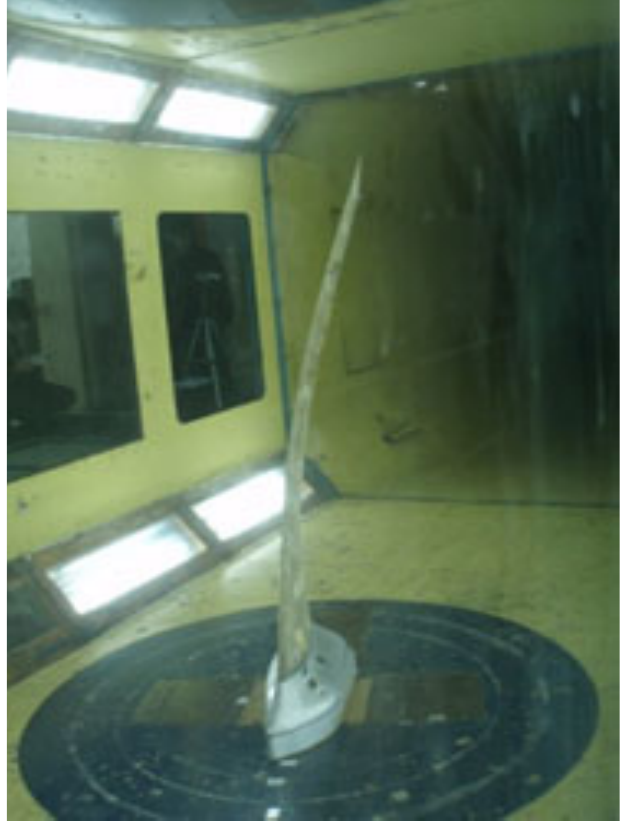
Figure 10. Low speed static aeroelastic test of high aspect ratio wing, Adapt with permission from [64].